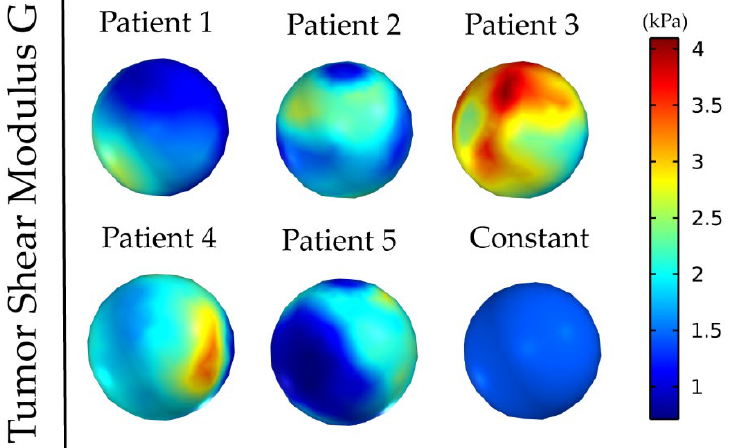
Figure 2. Patients’ tumor shear modulus, G, derived from MRE as it was fitted on the initial tumor seed of the model. The value for the constant shear modulus case is the average value of patient’s 1. The complex shear modulus G ∗ ( ω ) can be written as G ∗ ( ω )= G (cid:48) ( ω )+ G (cid:48)(cid:48) ( ω ) , where G (cid:48) and G (cid:48)(cid:48) are the storage and loss modulus calculated by MRE and given